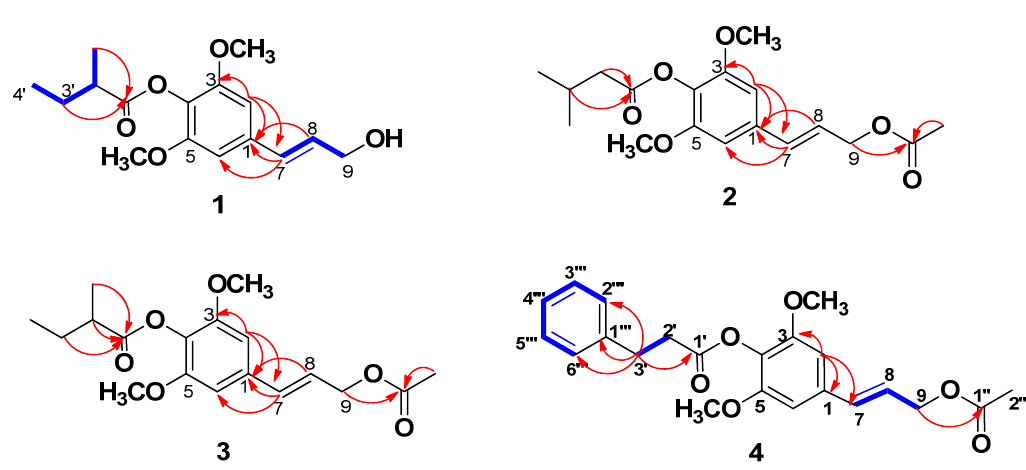
Figure 2. 1 H– 1 H COSY, HMBC for compounds 1 – 4